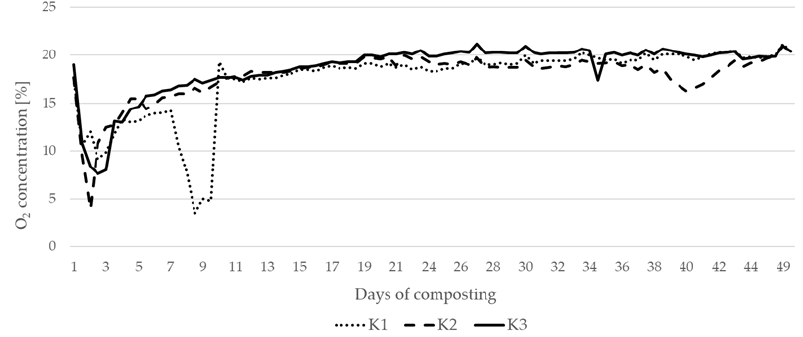
Figure 5. Concentration of the oxygen in the exhausted gas in analyzed